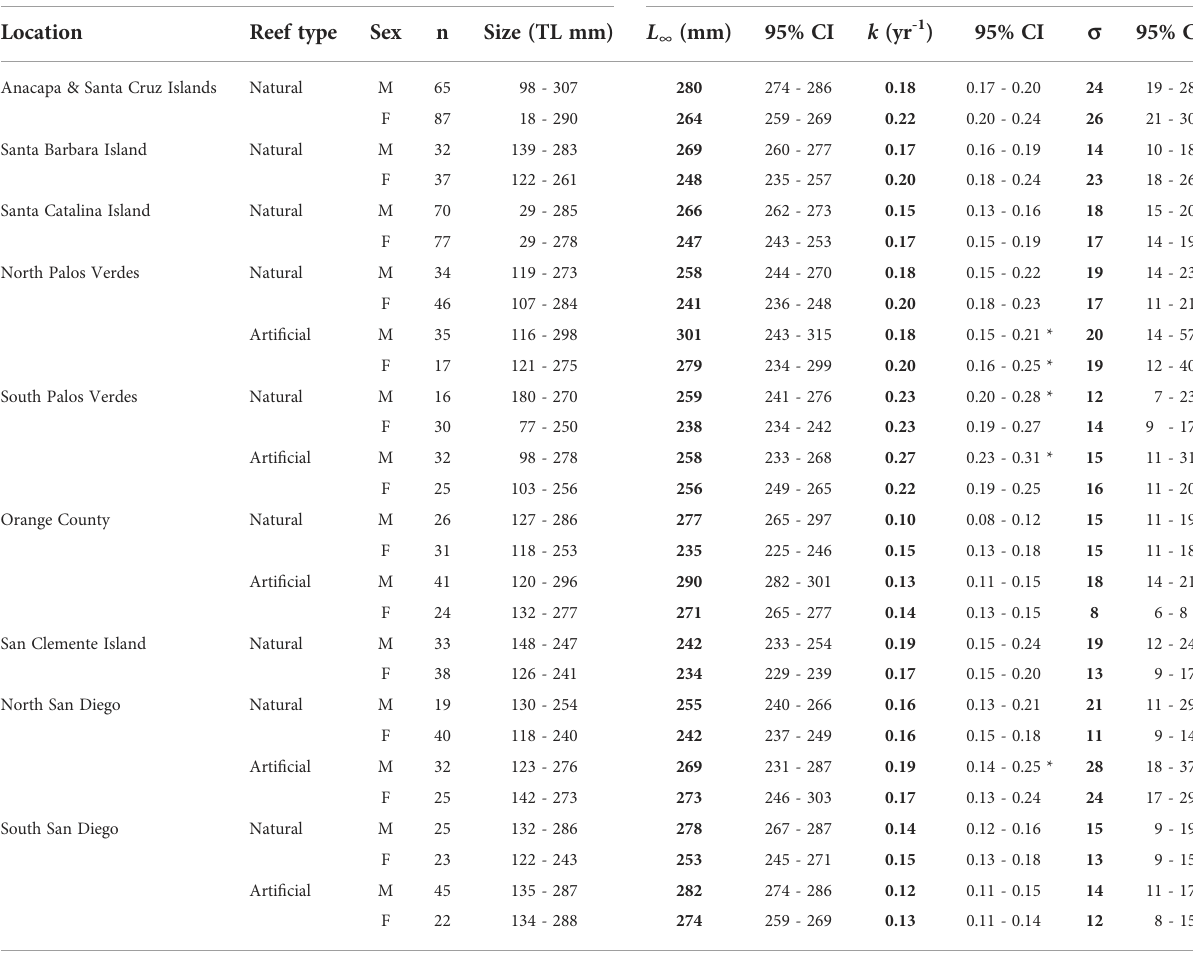
TABLE 2 Garibaldi ( Hypsypops rubicundus ) von Bertalanffy growth function parameters (bold) for the highest ranked (and most complex) model with bootstrapped 95% con fi dence intervals. Population Parameters and 95% Con fi dence Intervals